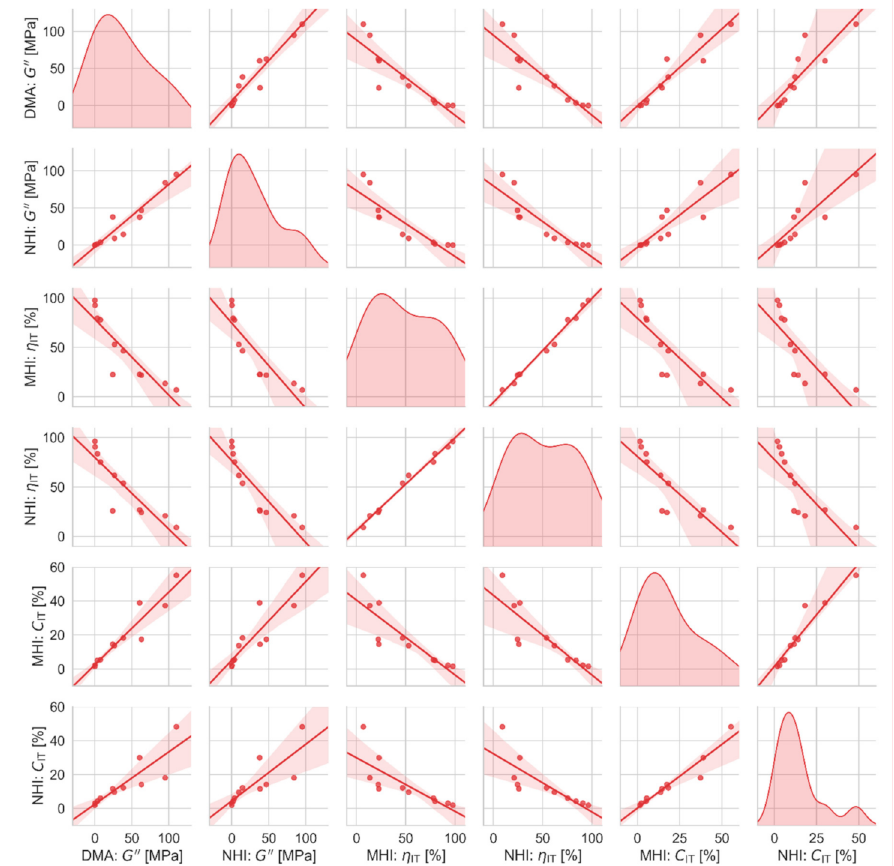
Figure 10. Scatterplot matrix graph showing correlations between selected viscosity-related properties in macro-, micro- and nanoscale: loss modulus from dynamic mechanical analysis (DMA / G ”), loss modulus from nanoindentation (NHI / G ”), elastic part of indentation work from micro-(MHI / η IT ) and nanoindentation (NHI / η IT ), and indentation creep from micro-(MHI / C IT ) and nanoindentation (NHI / C IT ). Diagonal elements of the scatterplot matrix graph display distributions of the individual quantities. O ff -diagonal elements show linear regression between the pairs of the